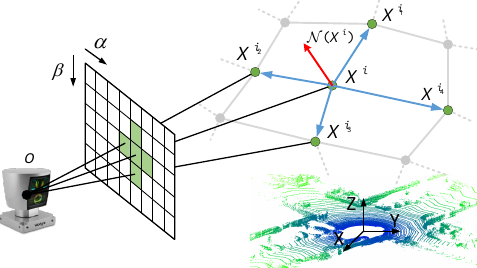
Figure 1. Illustration of data encoding and normal estimation.